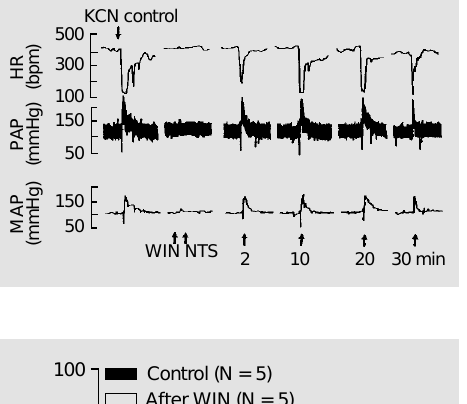
3 - Changes in mean arte- rial pressure ( D MAP) and heart rate ( D HR) in response to che- moreflex activation (KCN, 40 µg/ rat, iv ) before (control) and 2, 10, 20 and 30 min after bilateral mi- croinjection of WIN (2.5 nmol/50 nl) into the